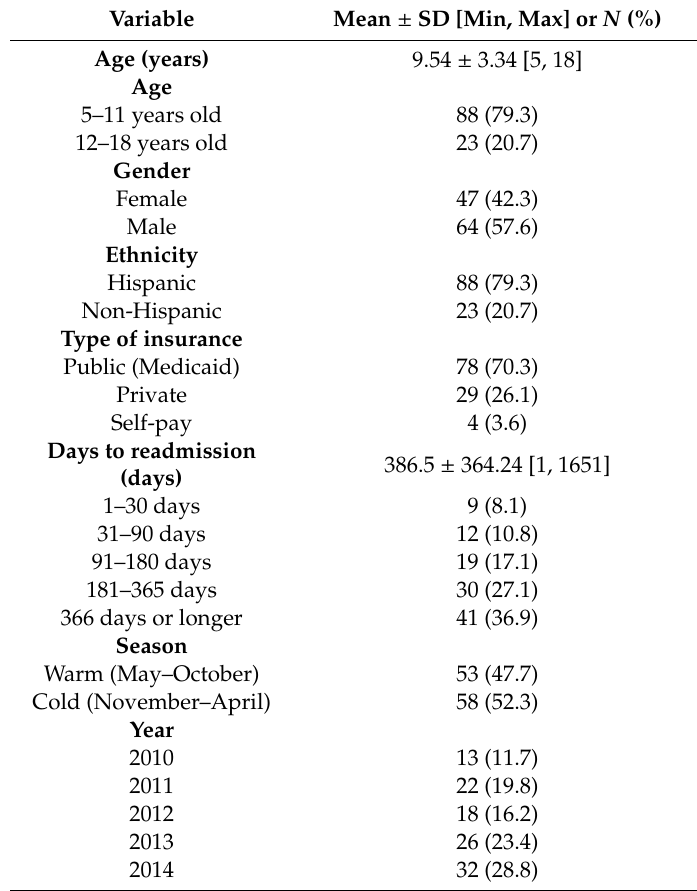
Table 1. Descriptive characteristics of asthma pediatric patients readmitted to the hospital between 2010 and 2014 ( N =